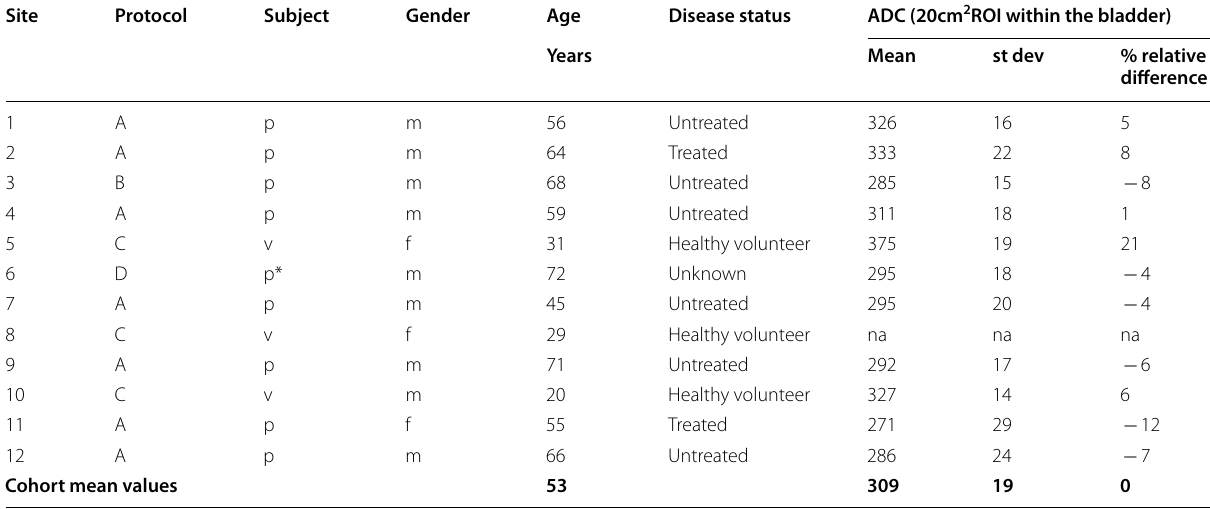
Table 5 Quantitative assessment of initial human data across all sites (same cohort as for Table 4): measurements of ADC values of the bladder